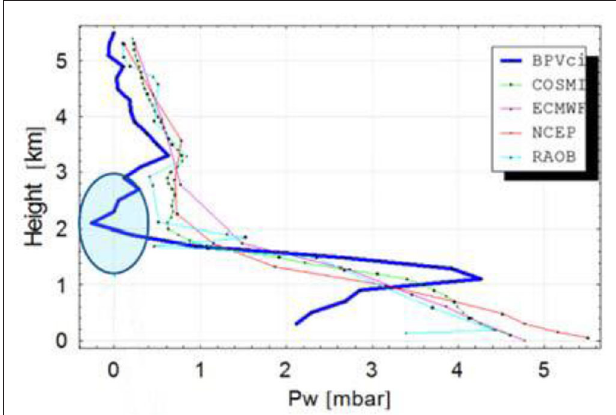
FIGURE 3 | A typical unphysical behavior of the wet pressure profiles by the previous BPV model. The negative value of the wet pressure is emphasized by the cyan